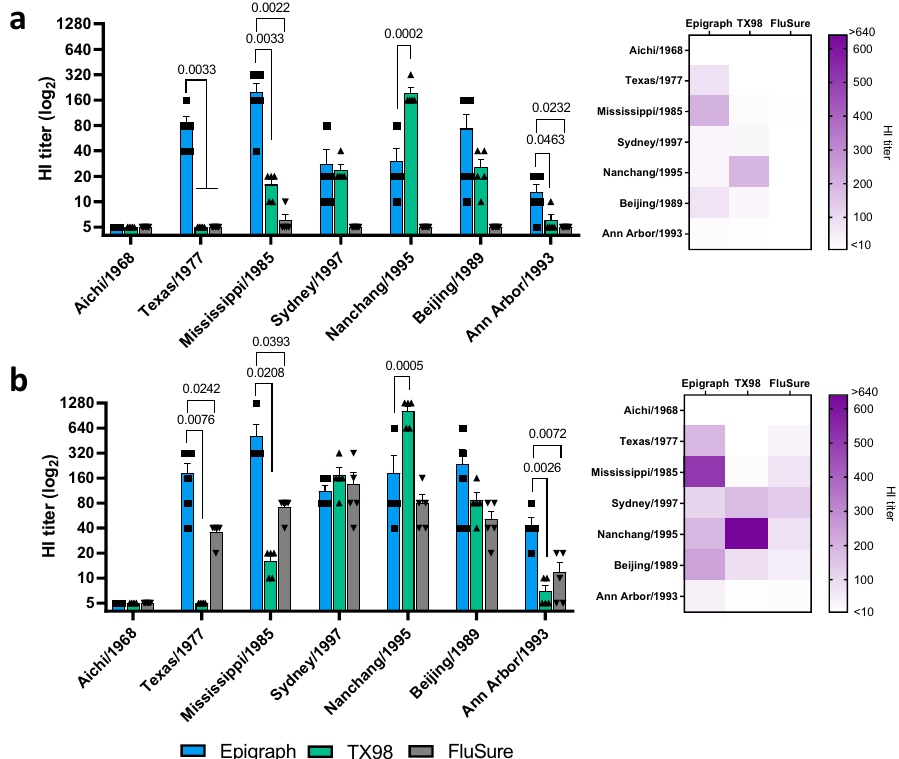
Fig. 7 Immune responses to human H3 strains after vaccination in swine. The sera from the vaccinated swine ( n = 5) were analyzed for cross-reactivity to huH3 strains using an HI assay against the panel of representative 7 huH3 strains. Antibody responses were examined after a single shot ( a ) or boosting ( b ) and a heat map of these HI titers was constructed to further visualize the total cross-reactive antibody response of each vaccine ( n = 5; one-way ANOVA with Tukey ’ s multiple comparisons compared to the epigraph group). Data are presented as the mean with standard error